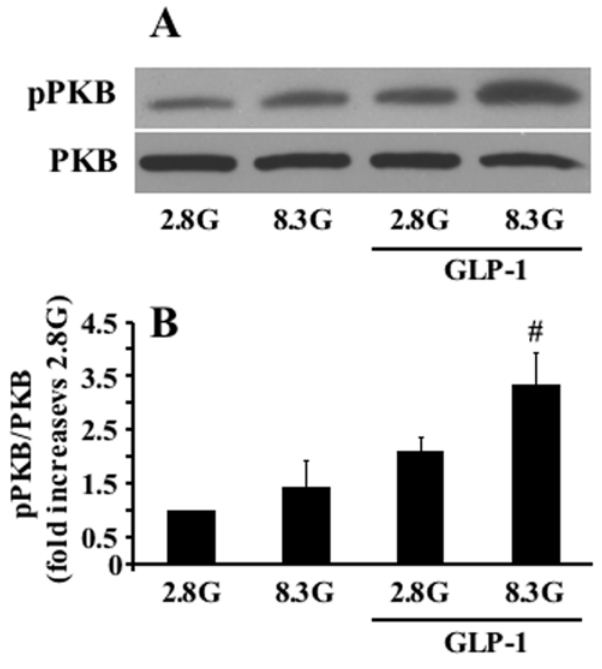
Figure 2. PKB phosphorylation in response to GLP-1 in rat islets. Islets were incubated for 30 min at 2.8 or 8.3 mM glucose in the presence or absence of 20 nM GLP-1. Activation of PKB by GLP-1 was assessed with antibodies specific for Ser 473 phospho-PKB and PKB, respectively. (A) Representative immunoblot of phospho- and total PKB in rat islets. (B) Quantitative measurement of PKB phosphorylation after 30 min treatment with GLP-1. Results are means 6 SE of 4 separate experiments. # p , 0.05, when compared to the corresponding ‘minus GLP-1’ group.